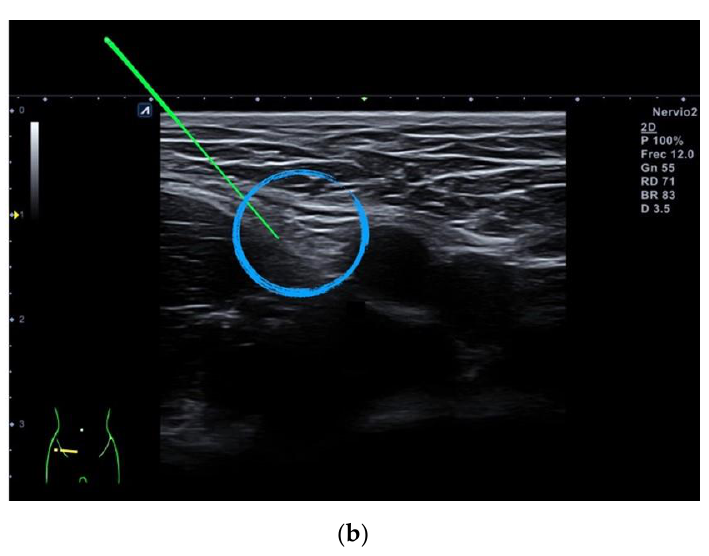
Figure 1. Femoral nerve ultrasound location for applying PENS over the left lower extremity: ( a ) Transducer placement; ( b ) ultrasound imaging of the femoral nerve.